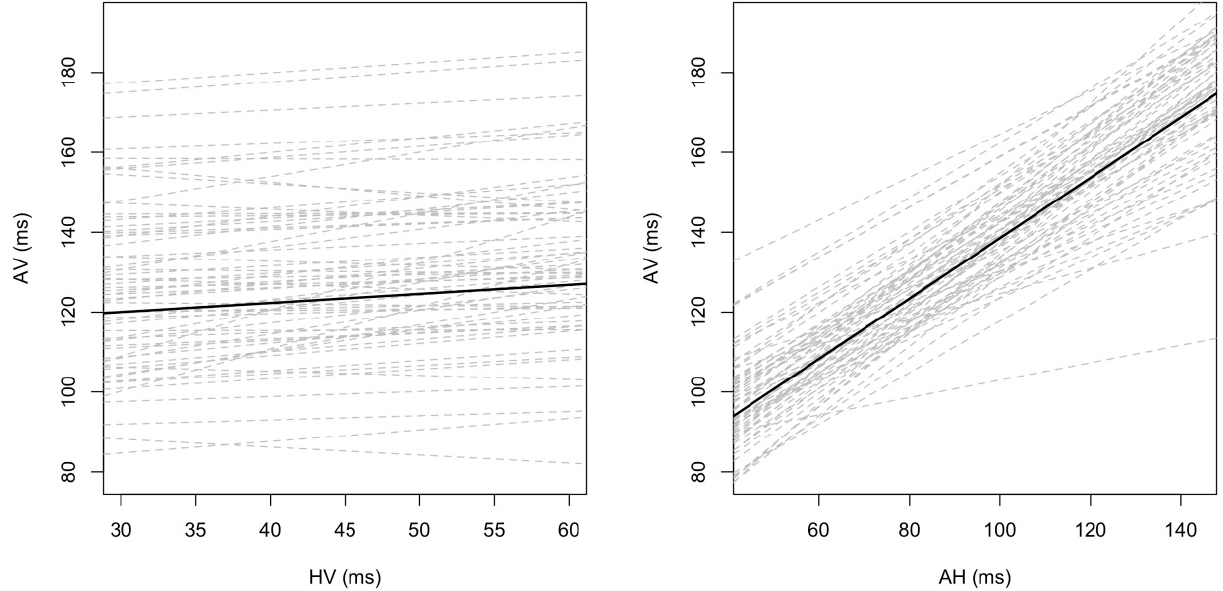
Figure 2. Dependency of AV intervals on AH and HV intervals. AH, HV, and AV—explained in the text.